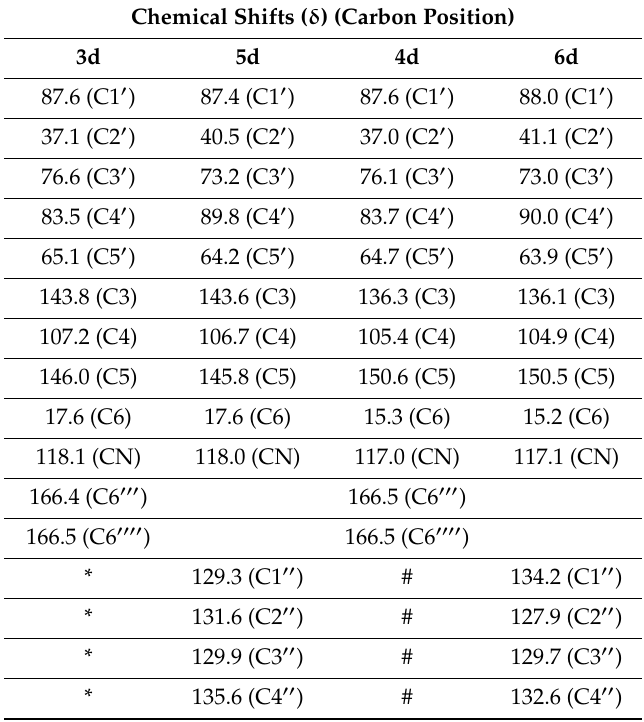
Table 3. Chemical shift values from the 13 C-NMR of compounds 3d , 4d , 5d, and 6d in acetone- d 6 . a Please refer to the structures in Table 4 for skeleton